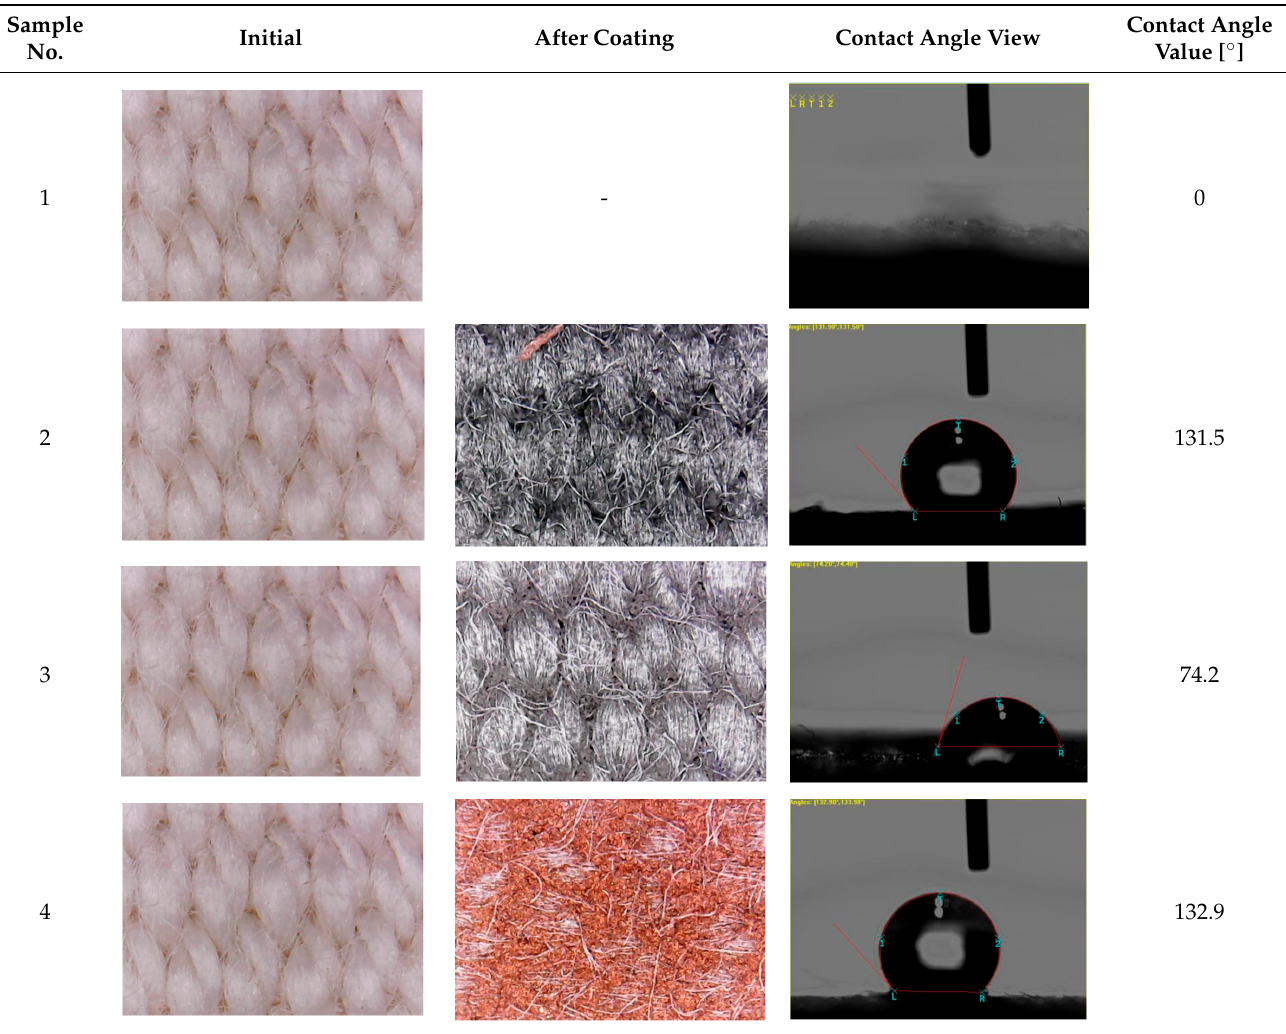
Table 4. Surface topography-optical microscopy and contact angle analysis. Table 4. Surface topography ‐ optical microscopy and contact angle analysis. Table 4. Surface topography ‐ optical microscopy and contact angle analysis. Table 4. Surface topography ‐ optical microscopy and contact angle analysis. Table 4. Surface topography ‐ optical microscopy and contact angle analysis. Table 4. Surface topography ‐ optical microscopy and contact angle analysis. Table 4. Surface topography ‐ optical microscopy and contact angle analysis. Table 4. Surface topography ‐ optical microscopy and contact angle analysis. Table 4. Surface topography ‐ optical microscopy and contact angle